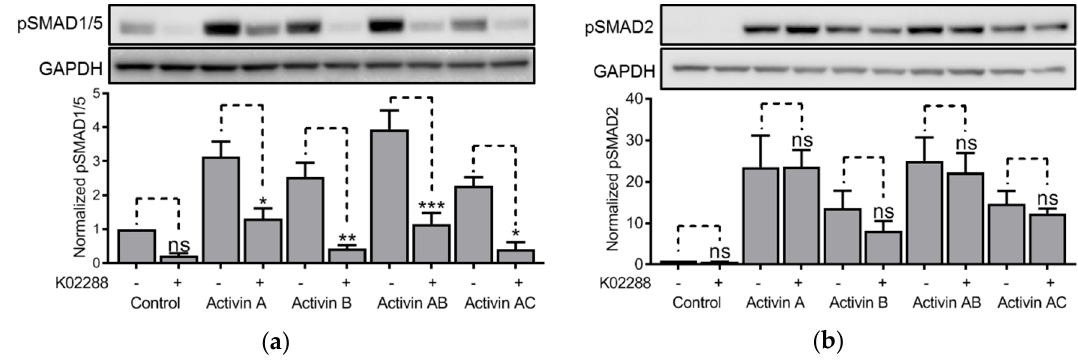
Figure 4. E ff ect of the bone morphogenic protein (BMP) type 1 receptor inhibitor, K02288, on activin-induced SMAD activity in HepG2 cells. HepG2 cells were treated for one hour with activin A, activin AB. Activin AC (20 ng / mL), or activin B (50 ng / mL) with or without K02288 (100 nM). Then, the phosphorylation status of SMAD1 / 5 ( a ) and SMAD2 ( b ) was measured by western blot. Representative experiments are shown (upper panels) and relative activation was calculated based on signal intensities of the SMADs and GAPDH for normalization (lower panels). The graphs represent mean ± s.e.m. of n = 3 independent experiments. Two-way ANOVA and Bonferroni’s multiple comparisons test were performed (* p ≤ 0.05, ** p ≤ 0.01, *** p ≤ 0.001, ns (not significant) p > 0.05).